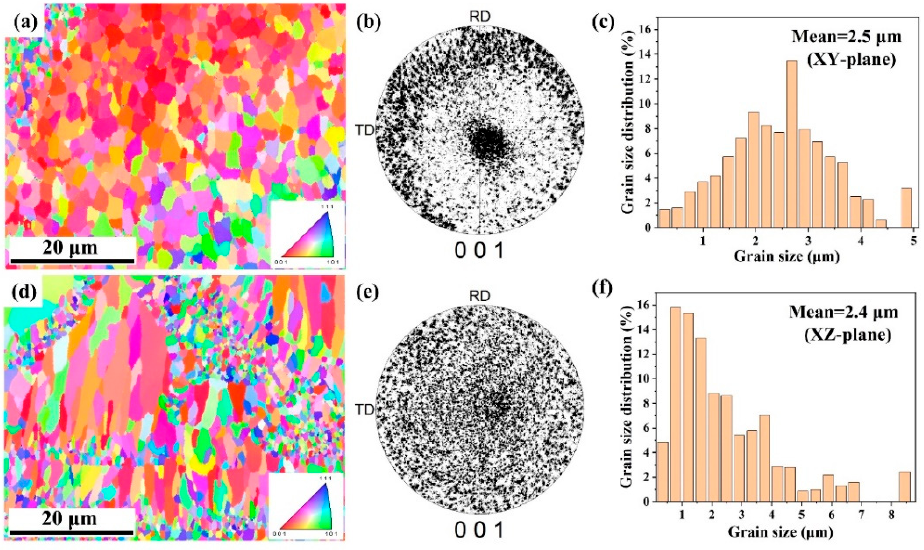
Figure 5. The EBSD results of the as − built sample on XY plane: ( a ) IPF, ( b ) [001] PF and ( c ) grain size distribution; XZ plane: ( d ) IPF; ( e ) [001] PF; ( f ) grain size distribution.